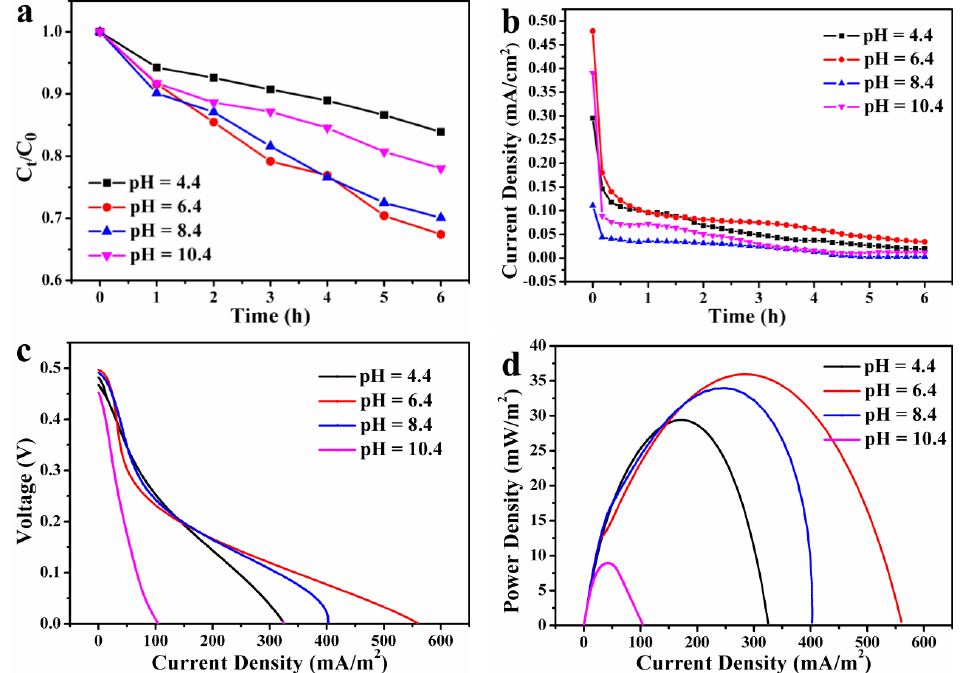
Figure 4. Effect of pH on ( a ) 4-CP degradation; ( b ) current density; ( c ) current-voltage plots and ( d